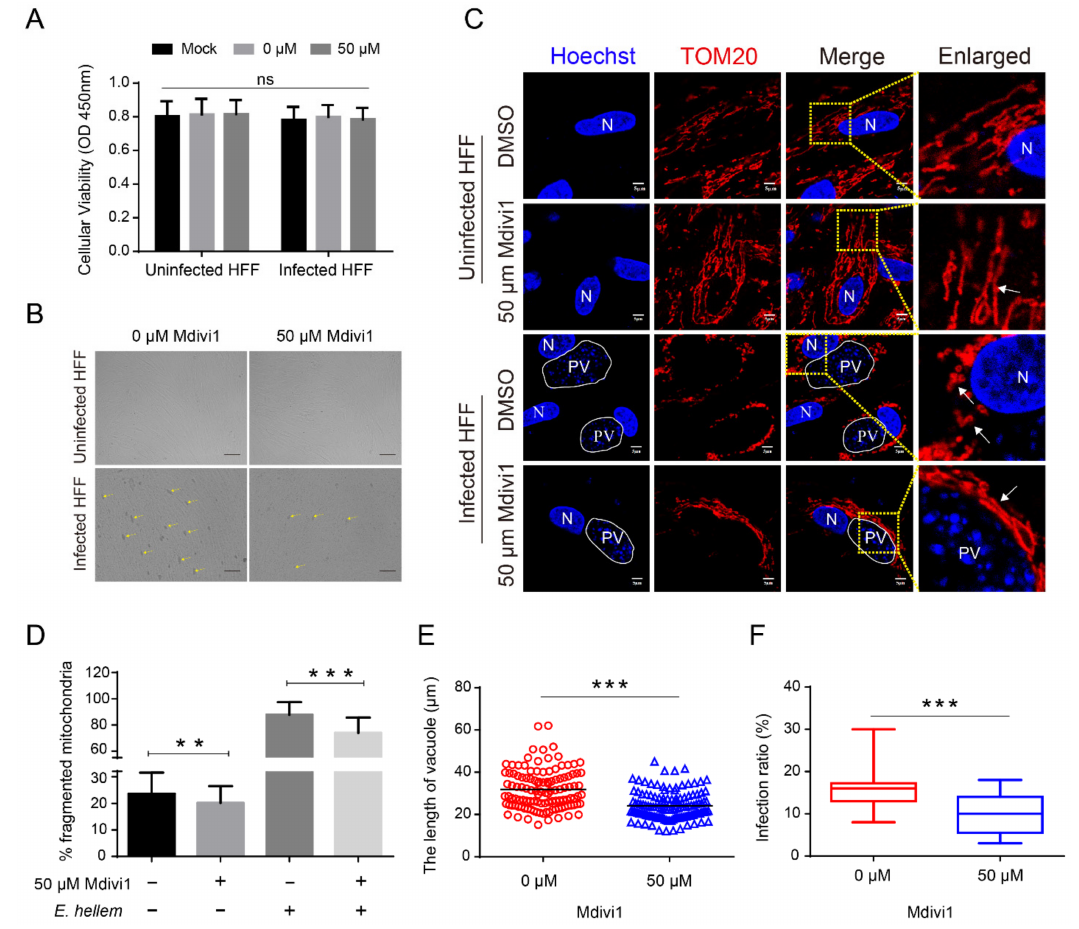
Figure 8. Analysis of the proliferation of microsporidia after inhibiting HMF at 48 hpi. HFF cells were treated with 50 µ M Mdivi1 for 4 h, and then Mdivi1 was removed by the replacement of the whole medium. The cells were then infected by E. hellem and again treated with Mdivi1 after 24 hpi. ( A ) Determination of cell viability upon Mdivi1 treatment. Mock, normal cells without treatment; 0 µ M Mdivi1, treatment by same volume of dimethyl sulfoxide (DMSO); ( B ) HFF cells infected by E. hellem at 48 hpi observed by light microscopy. Arrows indicate the PV of E. hellem . Bar, 100 µ m. ( C ) Observations of HMF in E. hellem -infected and uninfected HFF cells treated with Mdivi1. The nucleus is labeled with Hoechst (blue). Mitochondria were stained with antibody against TOM20 (red). PV, parasitophorous vacuole; N, nucleus; Bar, 5 µ m. ( D ) The percentages of HMF. A total of 100 cells were counted for three replicates with at least 30 cells for each replicate. ( E ) Analysis of the length of PV at 48 hpi after Mdivi1 treatment. At least 100 PVs from 10 fields for each sample were examined. Data of at least three separate experiments are expressed as scatter plots. ( F ) Statistical analysis of the infection rates in Mdivi1-treated cells. At least 10 fields for each sample were counted. ** p < 0.01, *** p <